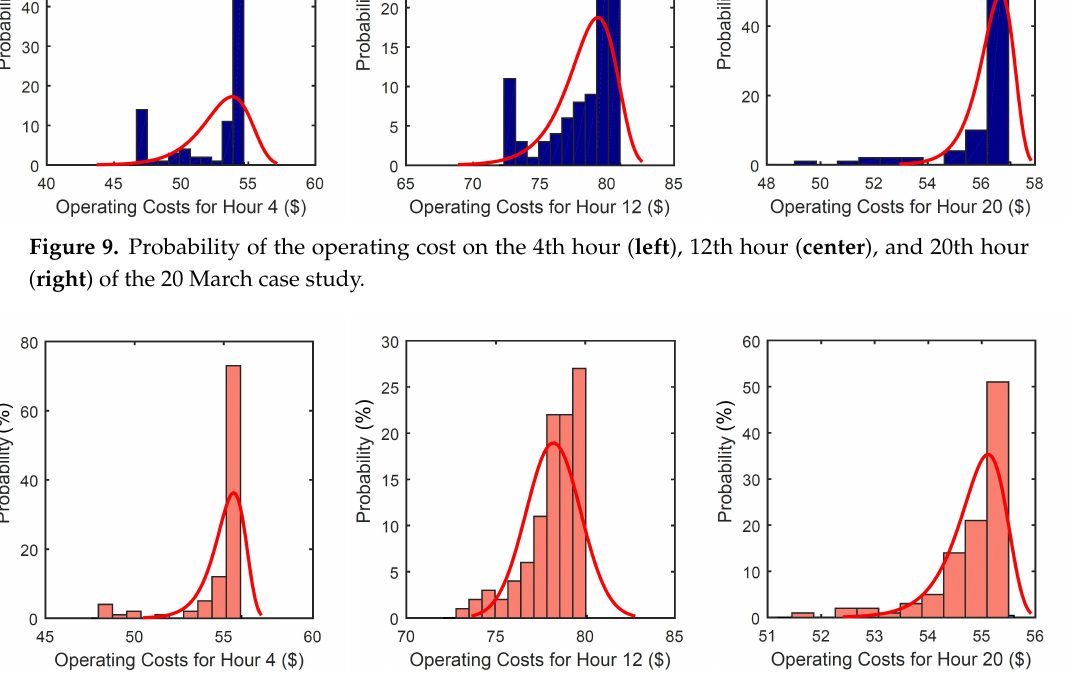
Figure 10. Probability of the operating cost on the 4th hour ( left ), 12th hour ( center ), and 20th hour ( right ) of the 21 June case